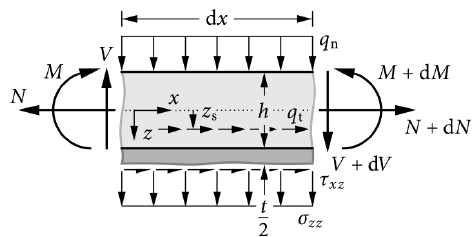
Figure 3. Free-body cut of an infinitesimal segment of length of the layered slab of height with half of the weak